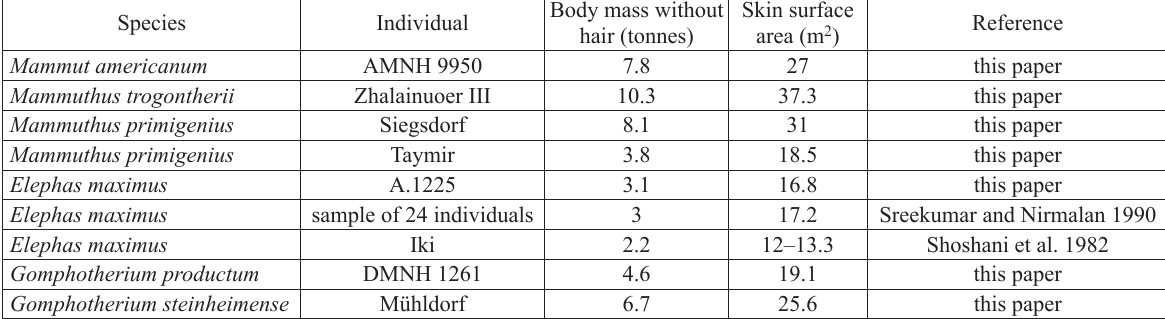
Table 6. Estimation of skin surface of different proboscideans, including extinct forms, that might have carried a thick layer of hair.